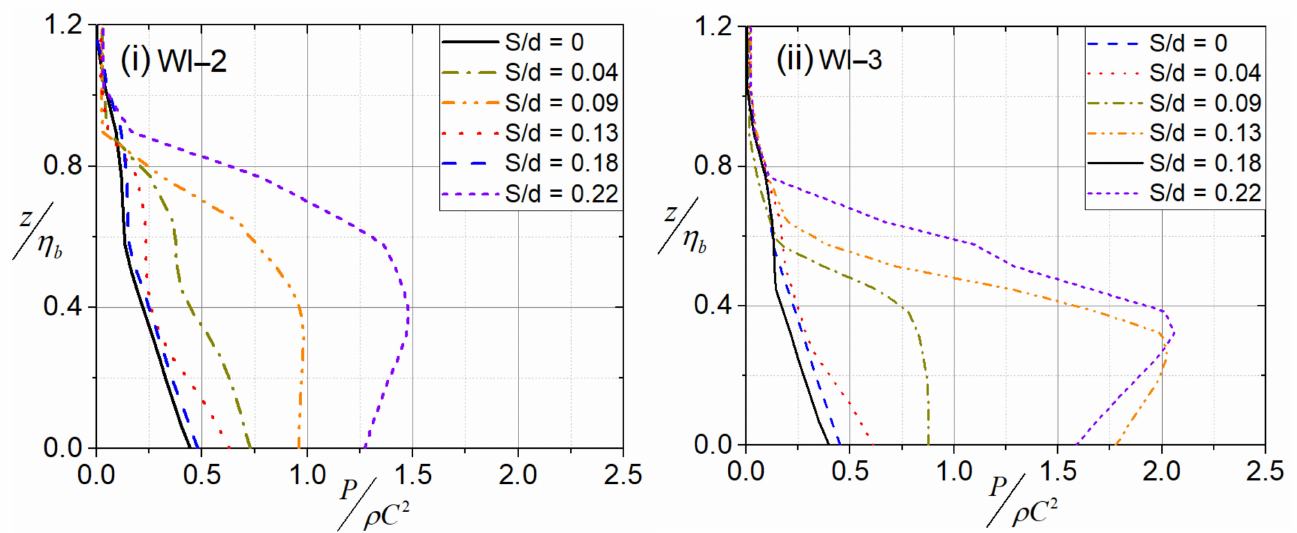
Figure 19. The variation of peak normalized pressure for structure placed at different normalized airgaps ( S/d = 0, 0.04, 0.09, 0.13, 0.18 and 0.22) during the wave impact scenarios: ( i ) WI-2 and ( ii )